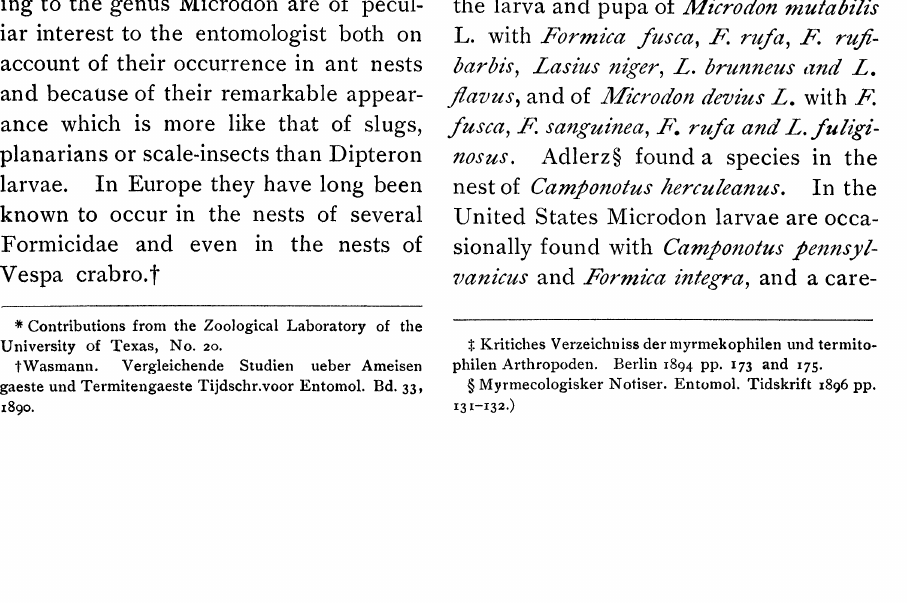
ing the peculiar alimentary canal of the genus, I8. Neelus minutus, n. sp. Fig. 3. Lateral aspect, X 122. Fig. 4. Lateral view of left antenna, X 506. Fig. 5. Right aspect of right fore foot, X ioo8. Fig. 6. Right aspect of right hind foot, )< 1008. Fig. 7. Ventral tube as seen from the left side, )< 269. Fig. 8. Ventral tube showing exsertile papillae, X 448. Fig. 9. Furcula. >( 269 Fig. IO. Furcula, from above, )< 224. Fig. I. Right aspect of left mucro,